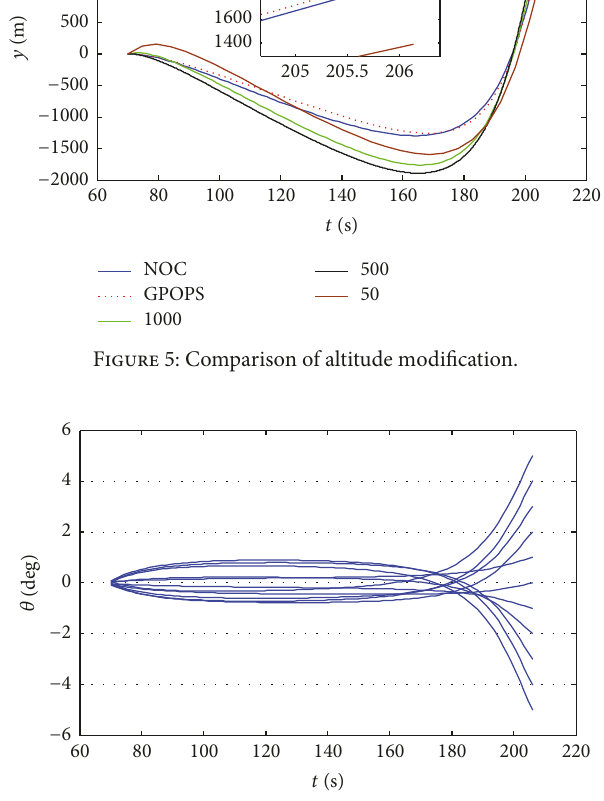
Figure 6: Flight path angle modifications with different terminals.